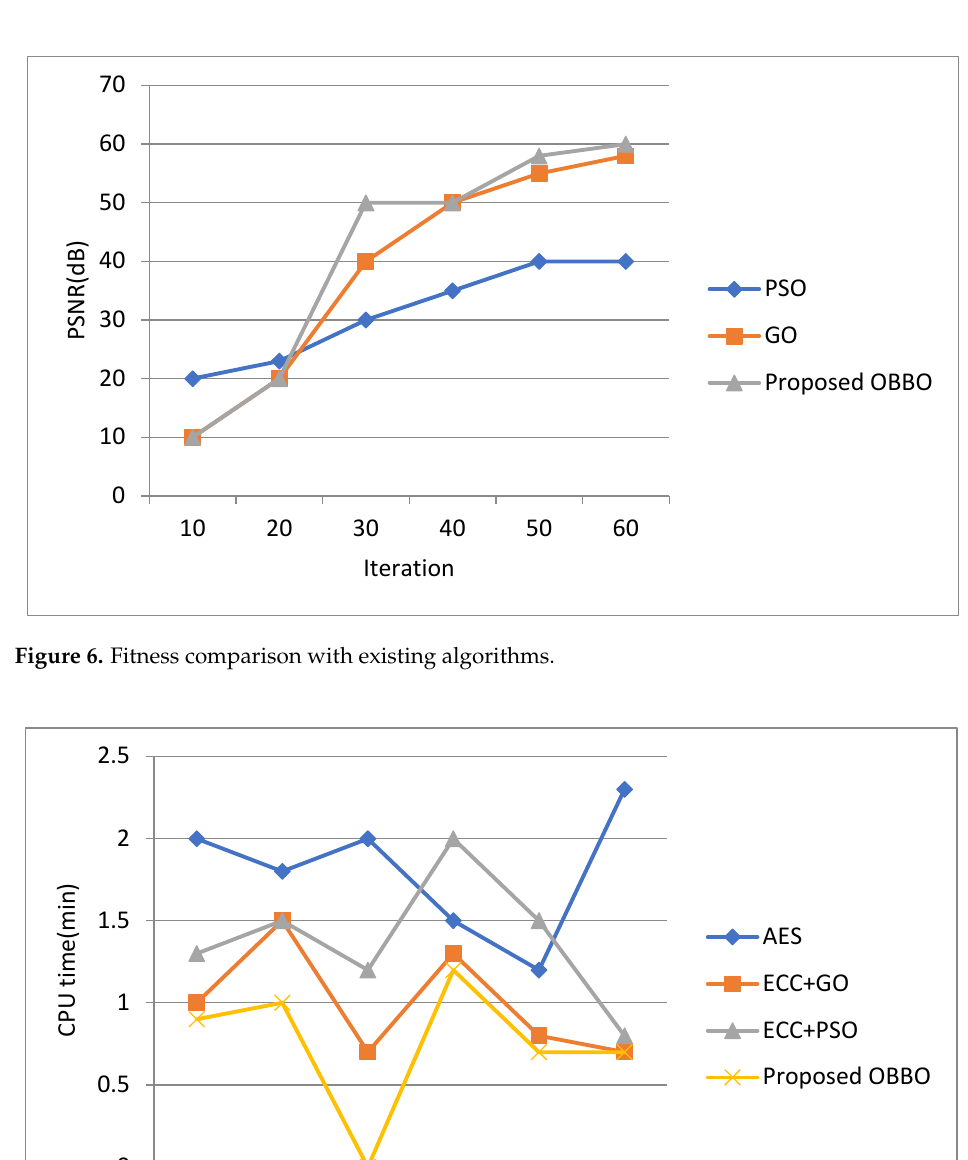
Figure 7. Running time comparison of proposed method with existing methods.